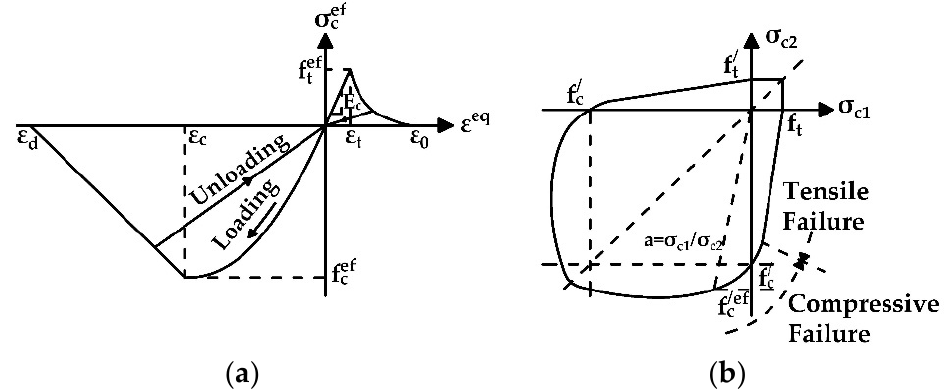
Figure 17. ( a ) Stress–strain curve for concrete; ( b ) biaxial failure function for concrete.